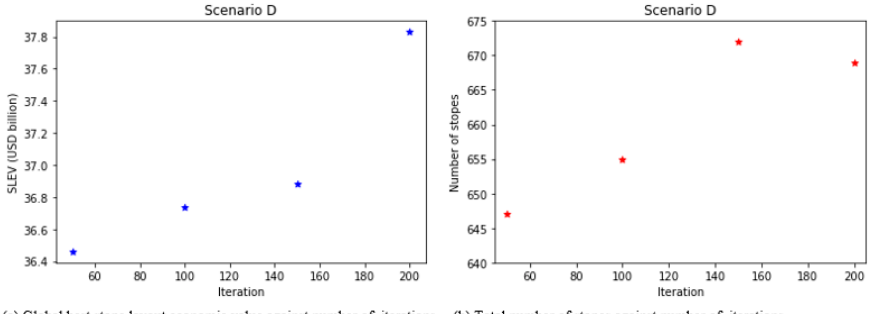
Figure 12. Scenario D: optimisation results of SLEV and number of stopes.